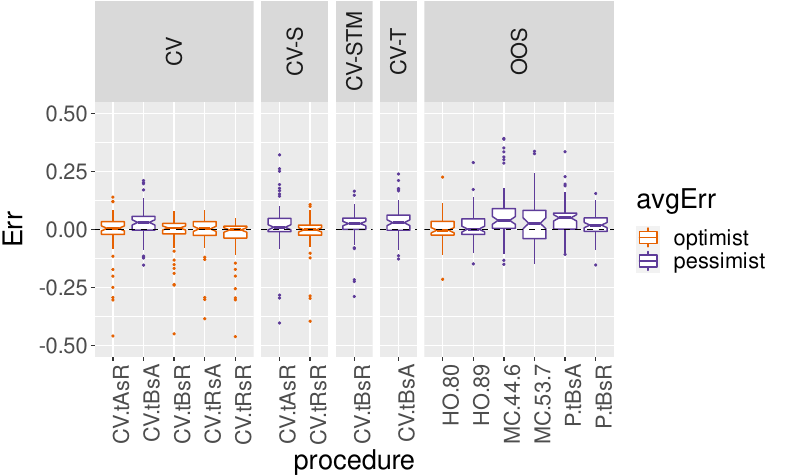
Figure 11. Box plots of estimation errors incurred by cross-validation and out-of-sample procedures on 17 real world datasets using four learning